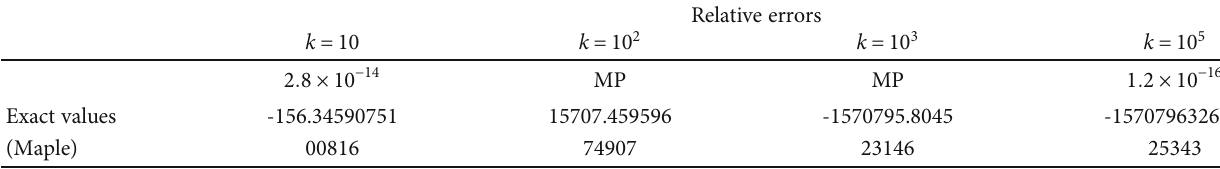
Table 2: Relative errors of the direct steepest descent method for .